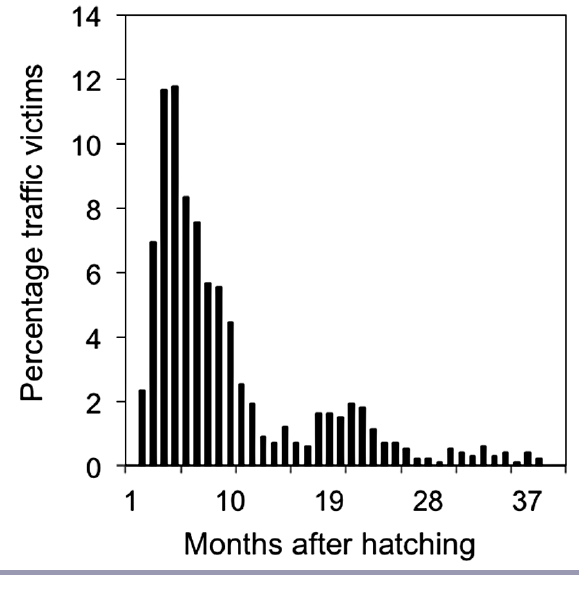
Fig. 5 . Frequency distribution of age after hatching of Barn Owls ( Tyto alba ) killed along roads (N = 994). Most traffic victims were within their first year of life and 12% lived for more than 40 months after hatching (not in the graph).